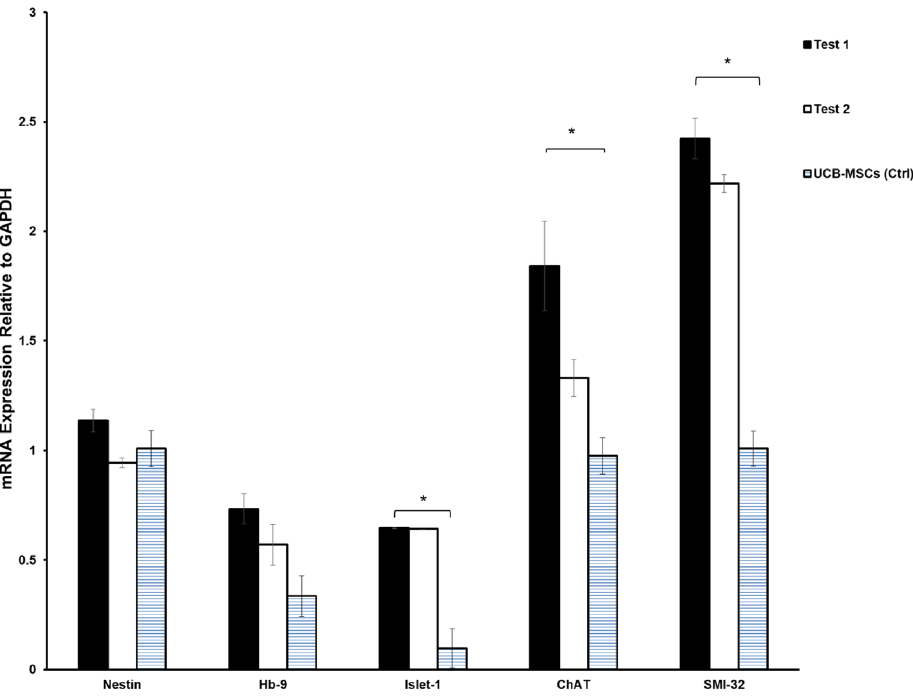
Figure 3. The expression pattern of motor neuron- related markers at the level of mRNA. The significant upregulation of Islet-1, SMI-32 and ChAT was observed in test groups when compared with the control (hUCB- MSCs; P < 0.05). No significant upregulation was observed in the expression of HB-9. The expression of Nestin was observed in the treated cells and MSCs as the control group. Values are expressed as the mean ± SEM.